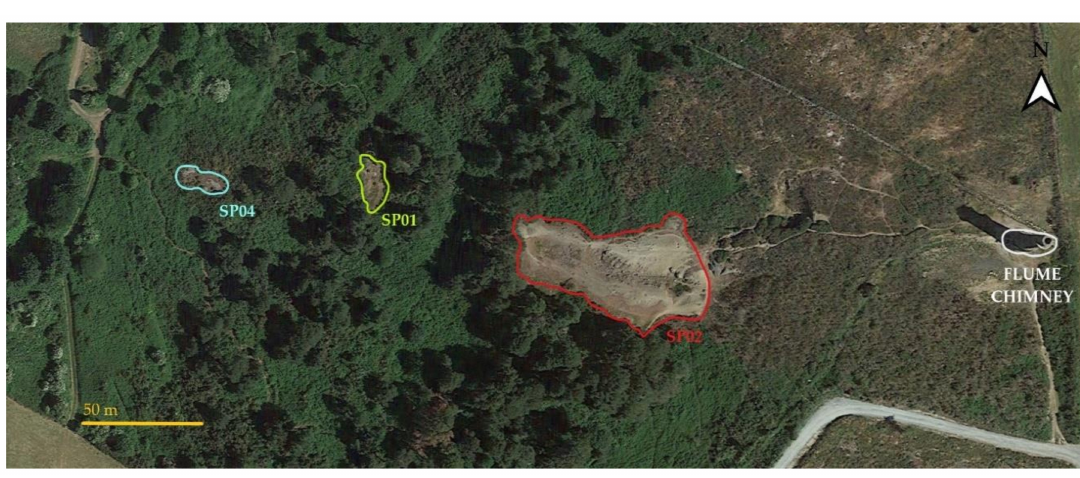
Figure 2. Ballycorus site map and spoil heaps (SP02, SP01, SP04). The flume chimney (highlighted in white) was the mine shaft site and was constructed in the early 1860s to vent the smelter smoke. SP02 was the original site used for lead ore and solid waste produced by these excavations are still accumulated at the edge of the heap representing the main volume of exposed mine waste. SP01 and SP04 are smaller solid waste heaps